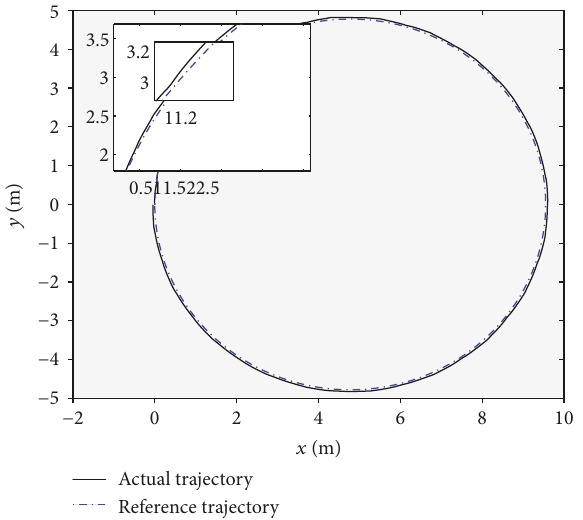
Figure 5: Position tracking (circle-path tracking).